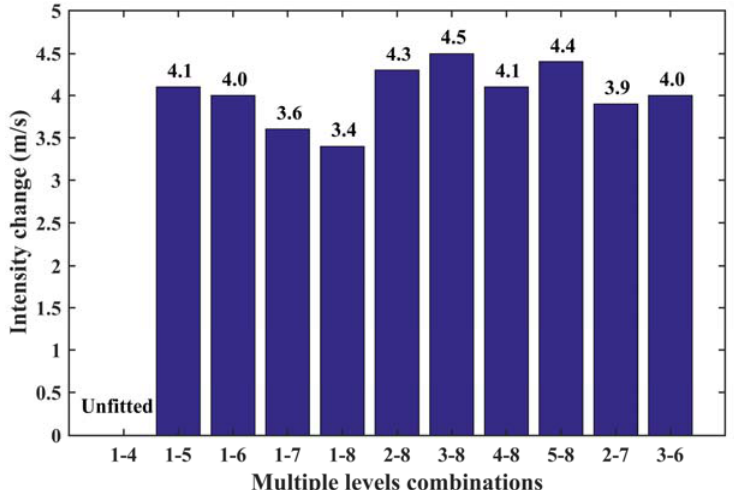
Figure 9. Performance comparison of multi-level combinations of TC variables: 1–8 = 100 hPa-sea surface, 1–7 = 100–1000 hPa, 1–6 = 100–850 hPa, 1–5 = 100–700 hPa, 1–4 = 100–500 hPa, 2–8 = 200 hPa-sea